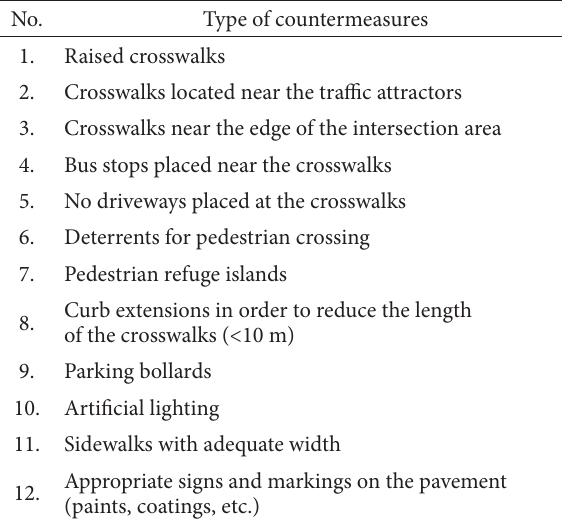
Table 2. Design features for pedestrian safety at intersections (Canale et al. 2009)